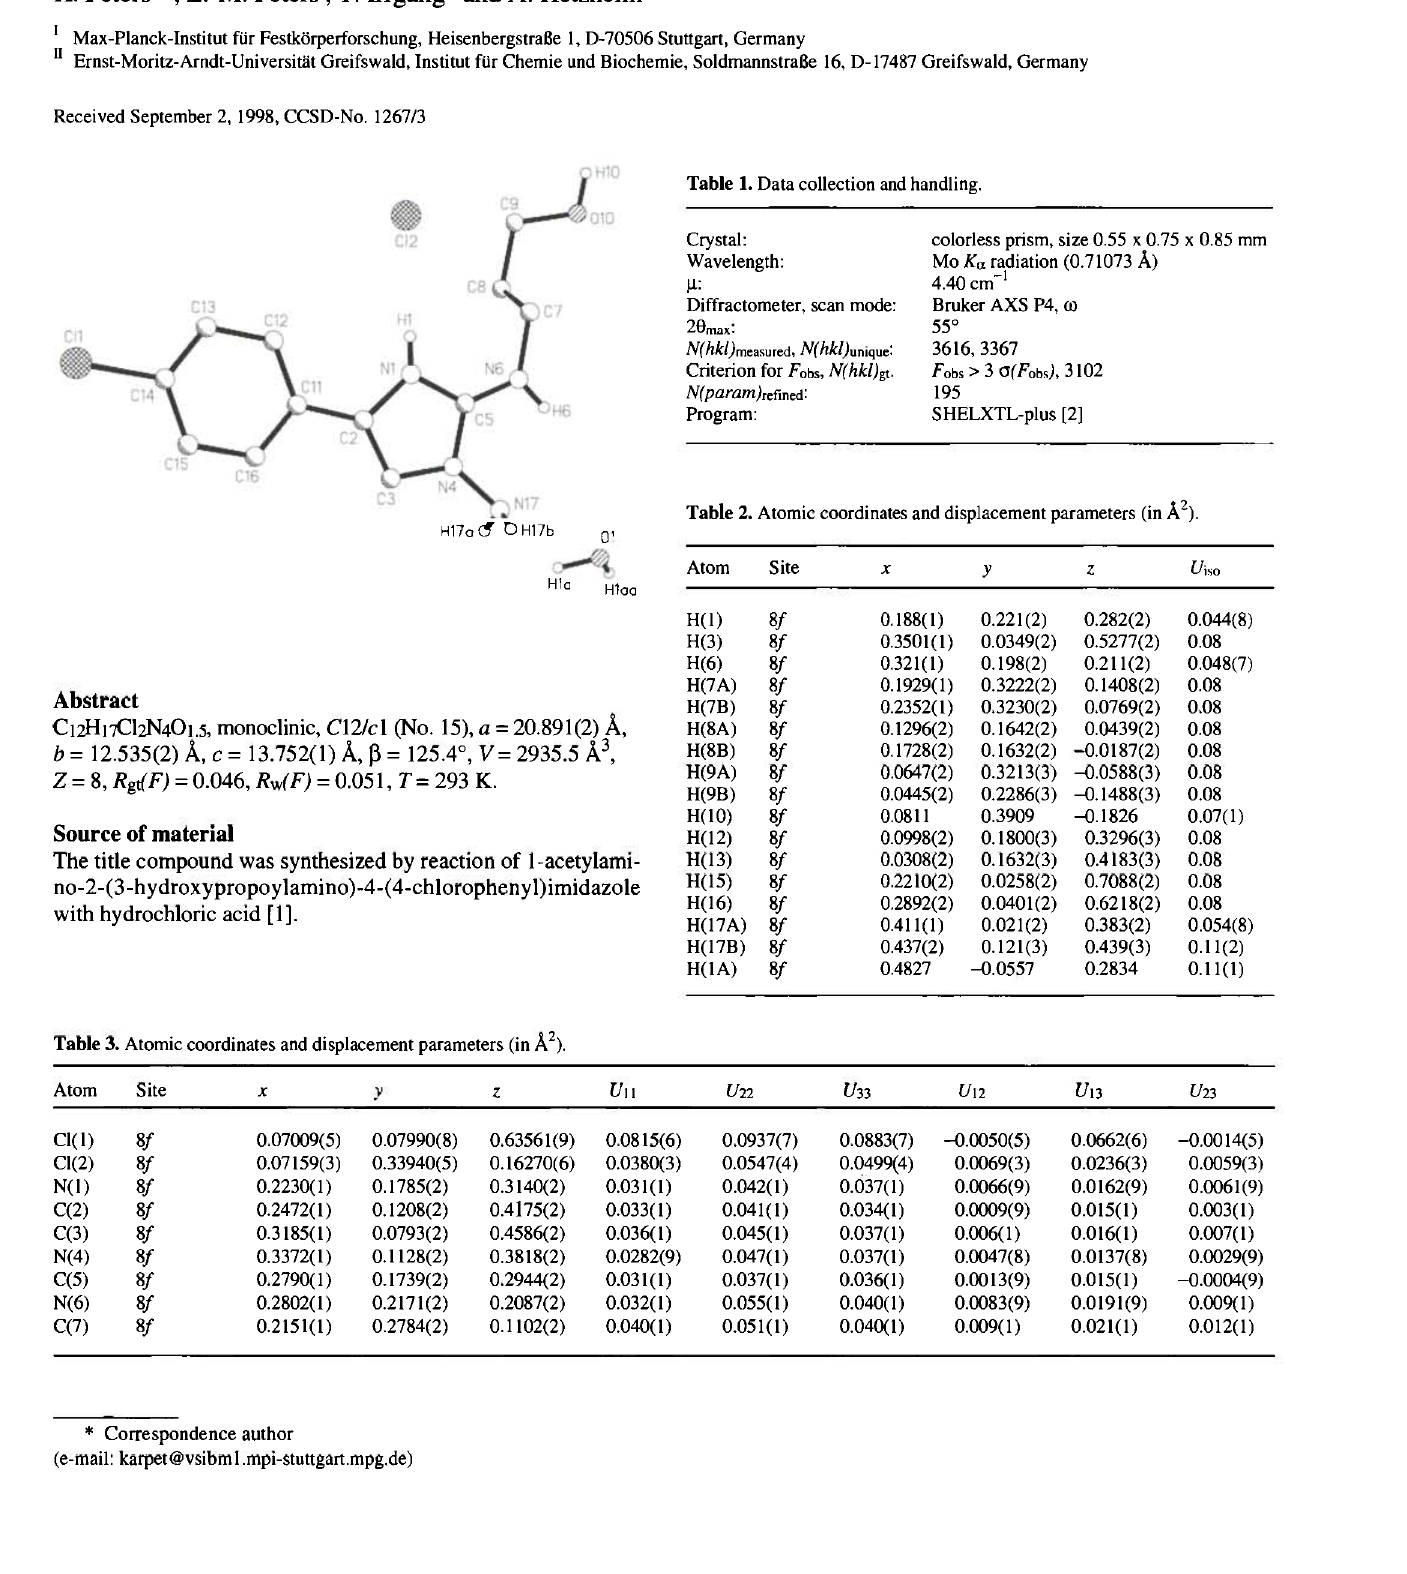
Table 1. Data collection and handling.